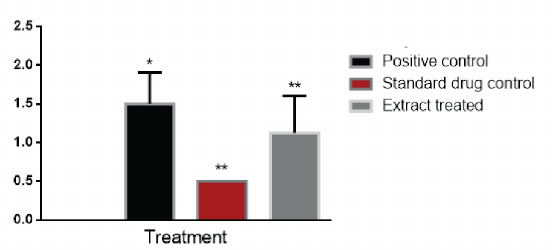
Figure 4 - Macroscopic evaluation of the stomach from negative control, positive control (5ml/kg), standard drug control and Myristica fragrans extract treated (200mg/kg) group of rats (* P <0.05; compared to negative control group, ** P <0.05 compared to positive control group;